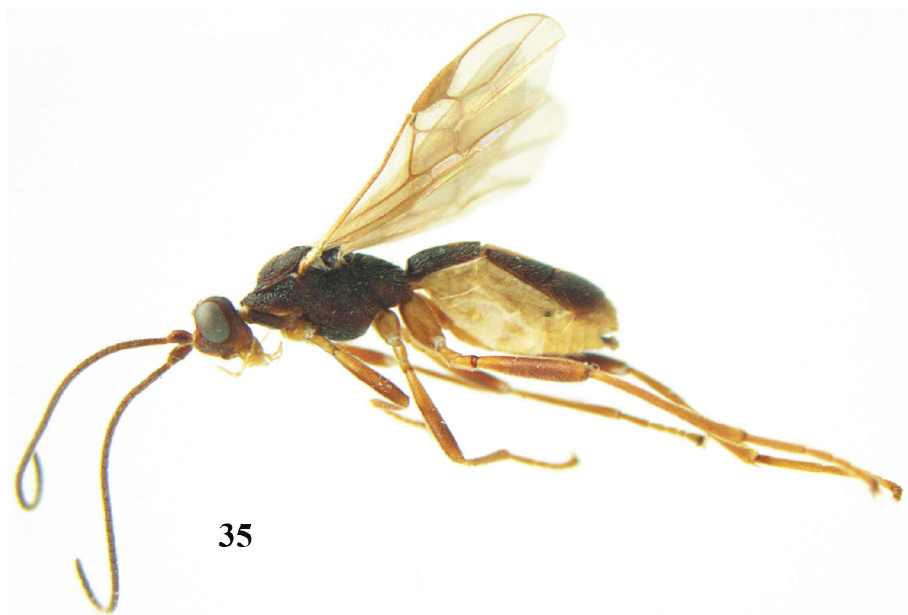
Figure 35. Aleiodes angustipterus sp. n., ♀ , holotype, habitus lateral.